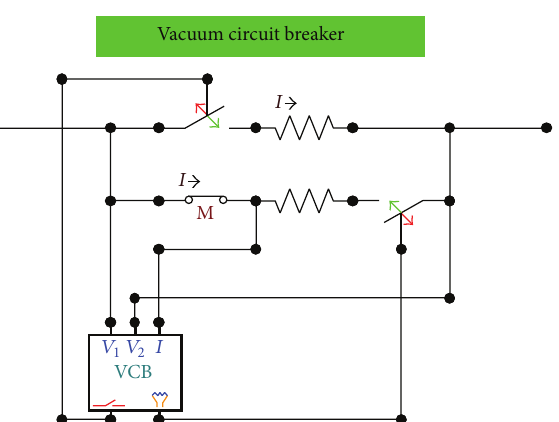
Figure 2: A propulsion system.